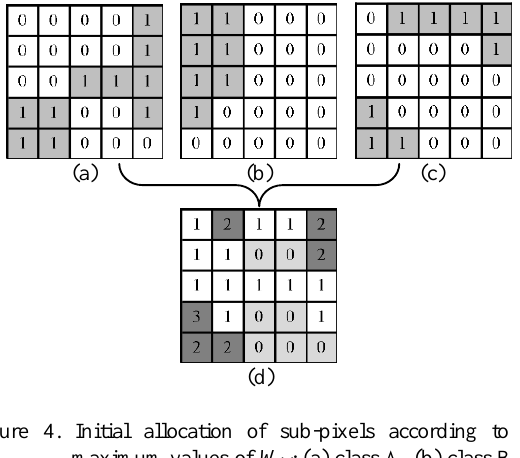
Figure 4. Initial allocation of sub-pixels according to the maximum values of W i,j : (a) class A, (b) class B, (c) class C, (d) there are some multiple and non- allocated